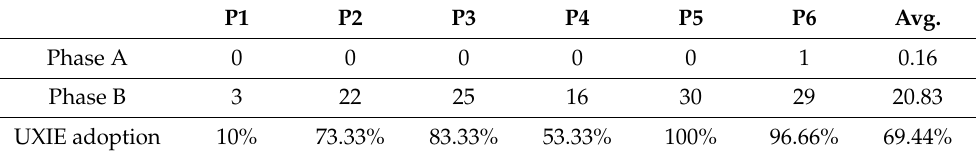
Table 4. Number of expert-based review metrics per evaluation